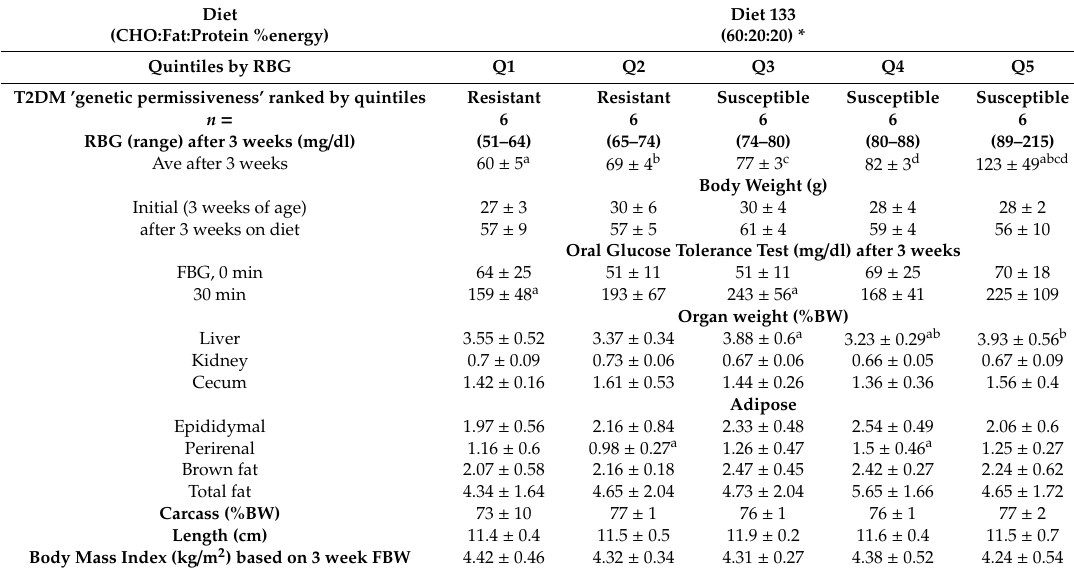
Table 6. (Experiment 4). Quintiles of RBG along with diabetes metagenetic profile for 30 female Nile Rats (3 weeks old) fed semipurified hiCHO Diet 133 (60:20:20)* for 3 weeks, then subdivided into ’resistant’ or ’susceptible’ quintiles based on RBG < 75 mg / dl > , respectively (NR Studies 133, 133(2), 139). Diet (CHO:Fat:Protein %energy)